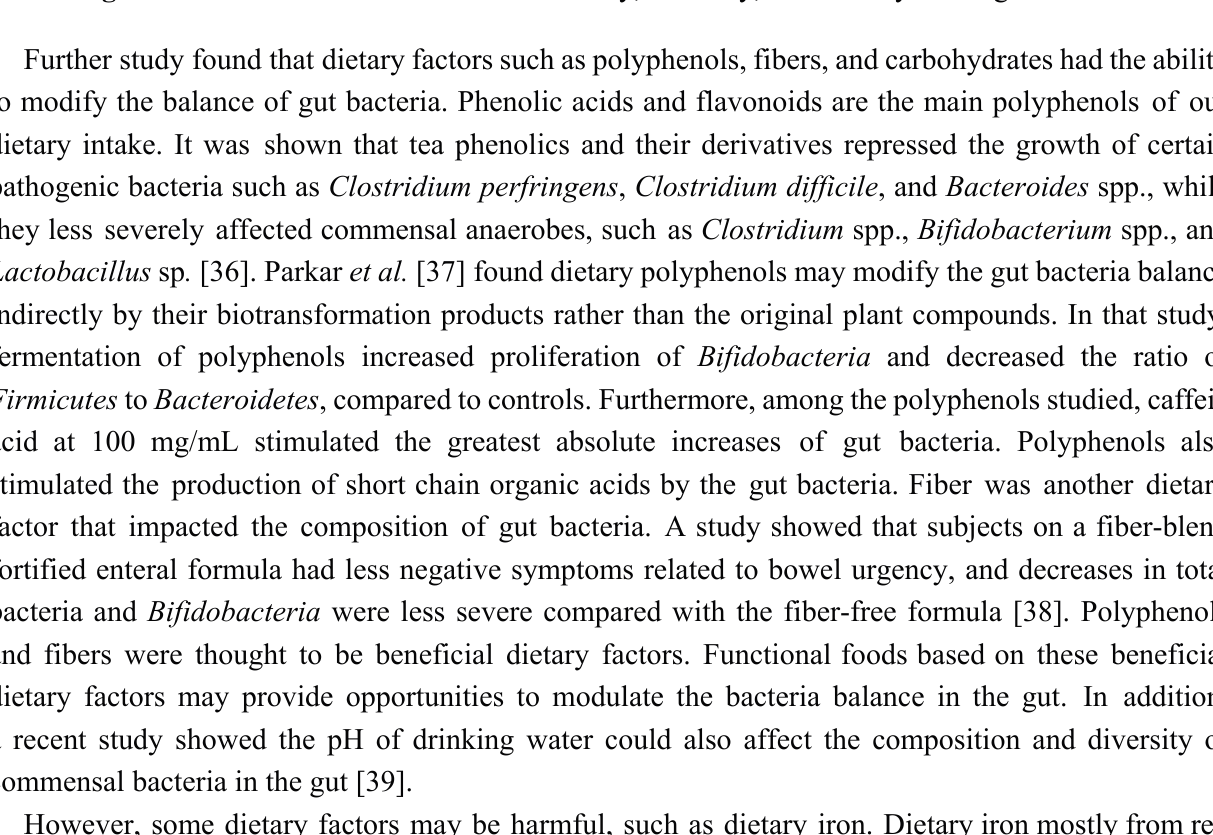
Figure 2. Several factors influence the density, diversity, and activity of the gut